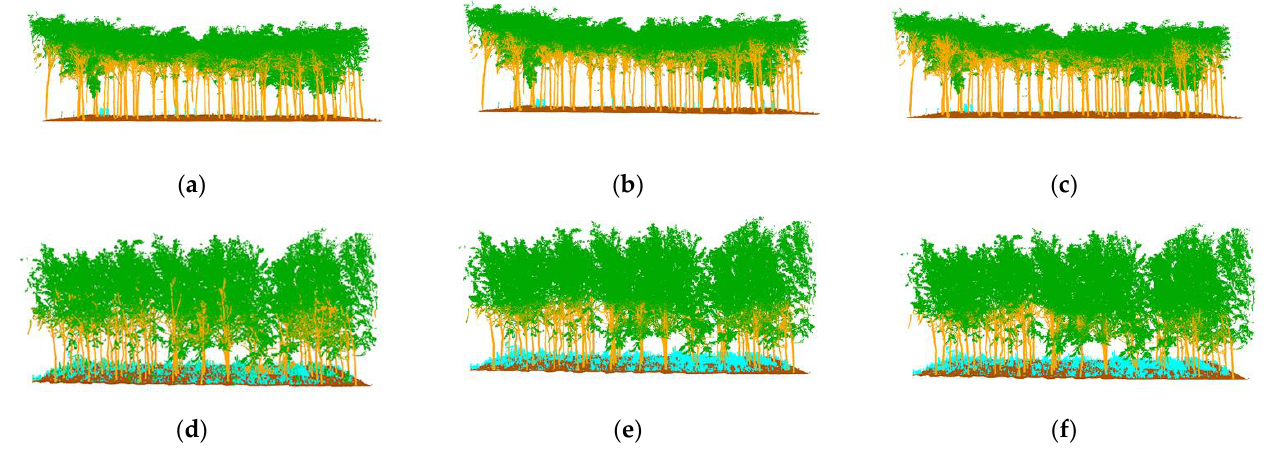
Figure 13. ( a , d ) MVF CNN segmentation; ( b , e ) PointNet segmentation; ( c , f ) PointCNN segmentation. Table 4. Comparison of the Precision of each method.